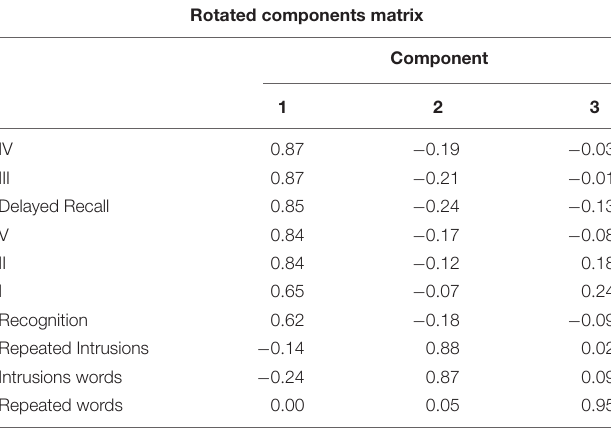
TABLE 4 | Correlation coefficients between RAVLT scores, memory and non-memory tests